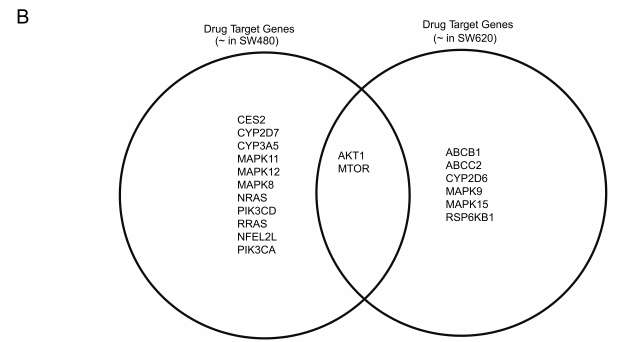
Figure 7. Graphical illustration of molecular interactions between the core-clock network, genes involved in hallmarks of cancer and circadian drug targets. ( A ) Target genes associated with cancer hallmarks and the circadian clock that were found oscillating in analysis. For genes that have multiple route to interact with the clock genes the numbered arrows indicate all potential interaction ways of the target genes to the core clock genes. ( B ) Circadian drug target genes oscillating significantly in analysis. Additionally, some of the candidate cancer associated genes in the diagram were also linked to Huntington’s disease (Table S1). These genes are highlighted with beige and negative regulators of the core circadian clock machinery with black circles. NDUFS3 is indirectly associated with the cancer but dominantly found in HD. “~” stands for significantly oscillating genes and dashed lines indicate the presence of indirect links to the circadian clock